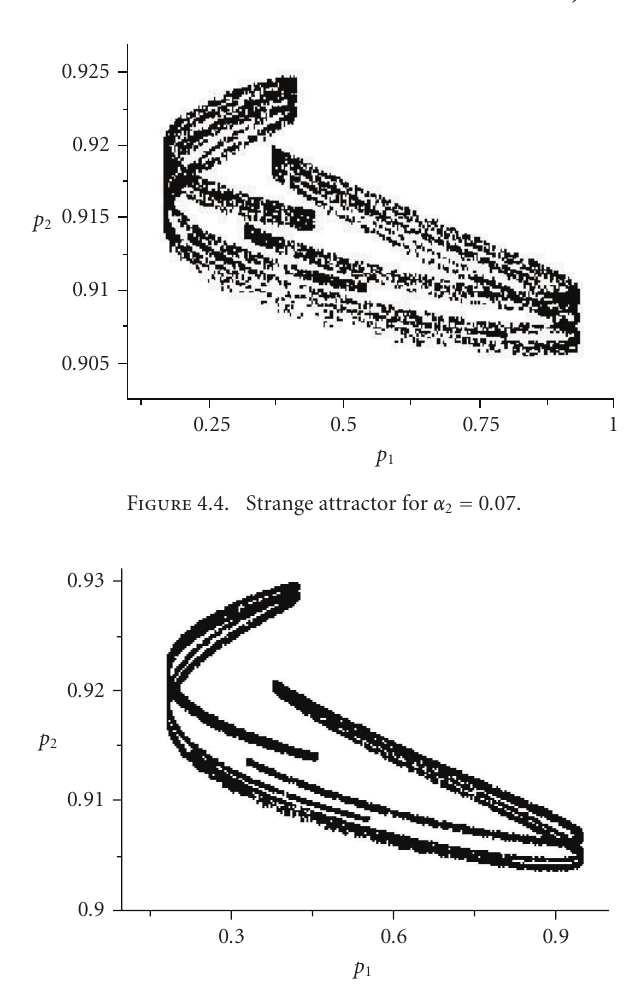
Figure 4.5 . Strange attractor for α 2 = 0 .